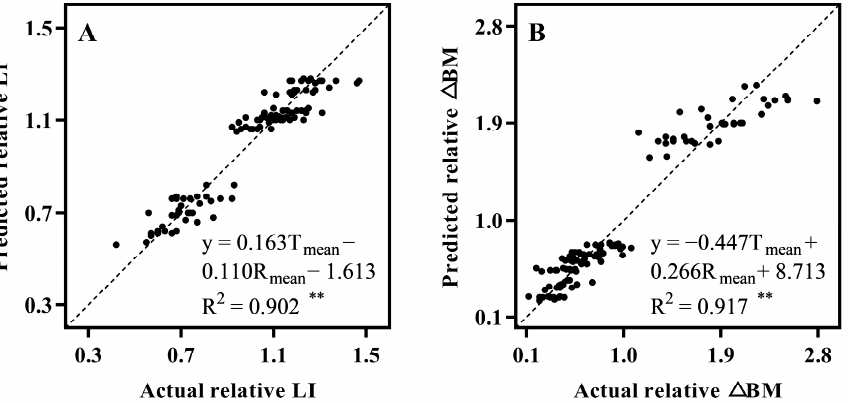
Figure 6. Stepwise regression analysis of the temperature and solar radiation parameters with the relative LI ( A ) and △ BM ( B ) of twelve indica rice cultivars. T mean , average daily temperature. R mean , average daily solar radiation. n = 108. **, significant differences at p < 0.01.